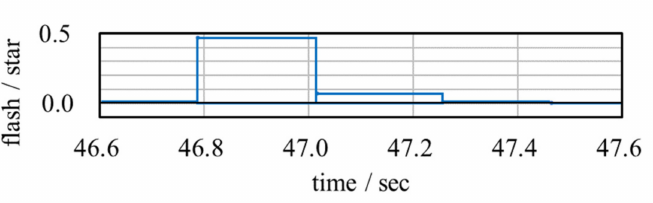
Figure 11. Light curve of Flash 1 as seen from Macei ó , in brightness ratio of the flash to the comparison star.